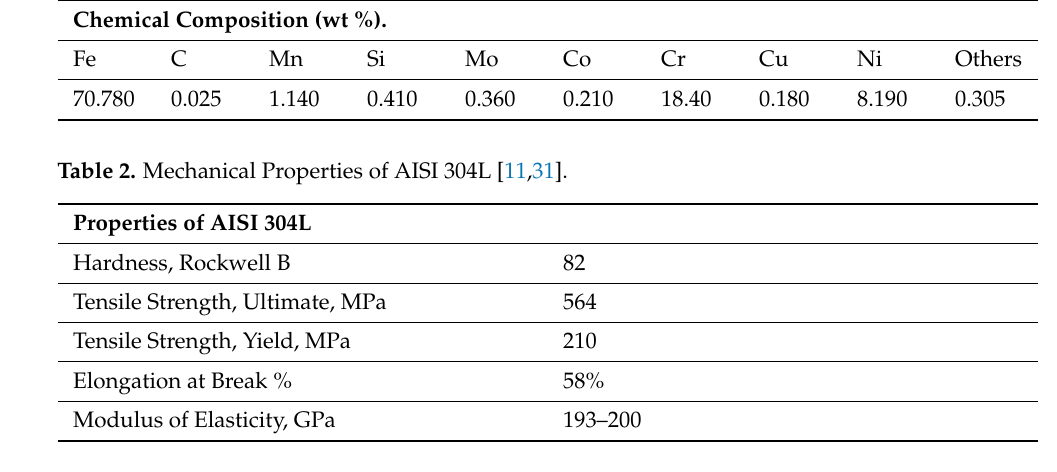
Table 1. Chemical composition in wt% of AISI 304L [11].